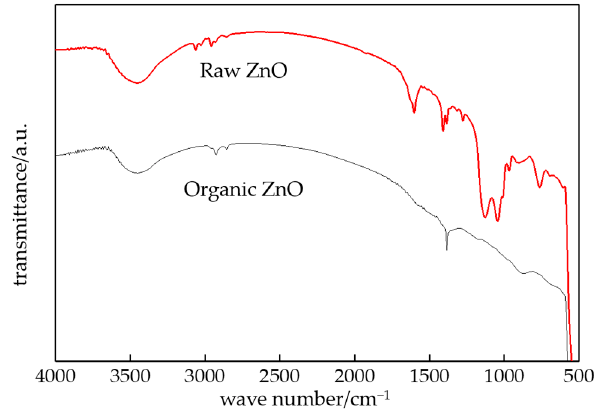
Figure 1. FTIR patterns of ZnO particles before and after surface modification.